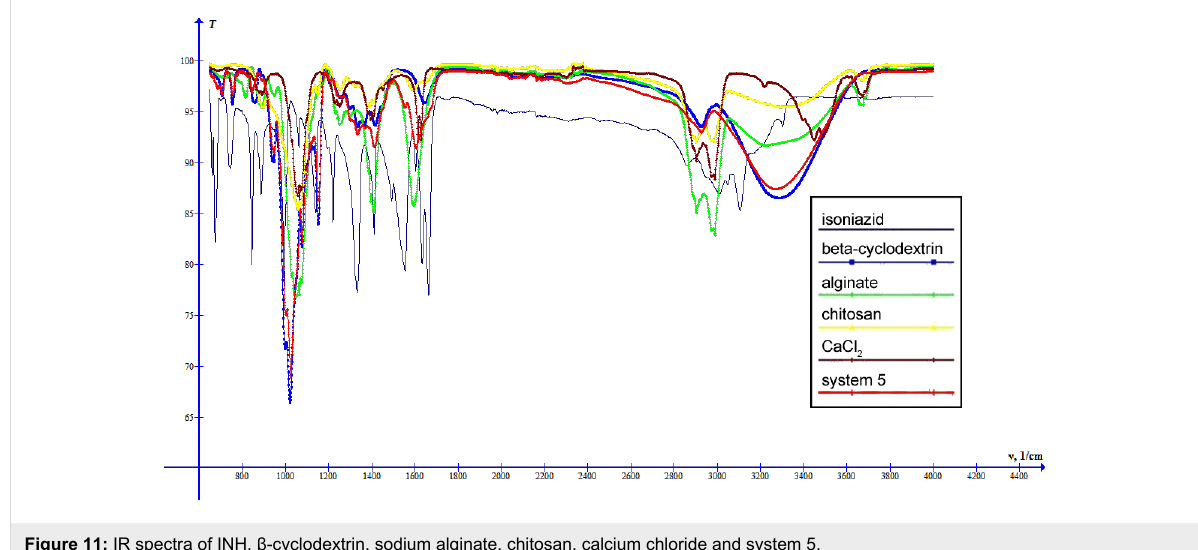
Figure 11: IR spectra of INH, β -cyclodextrin, sodium alginate, chitosan, calcium chloride and system 5.